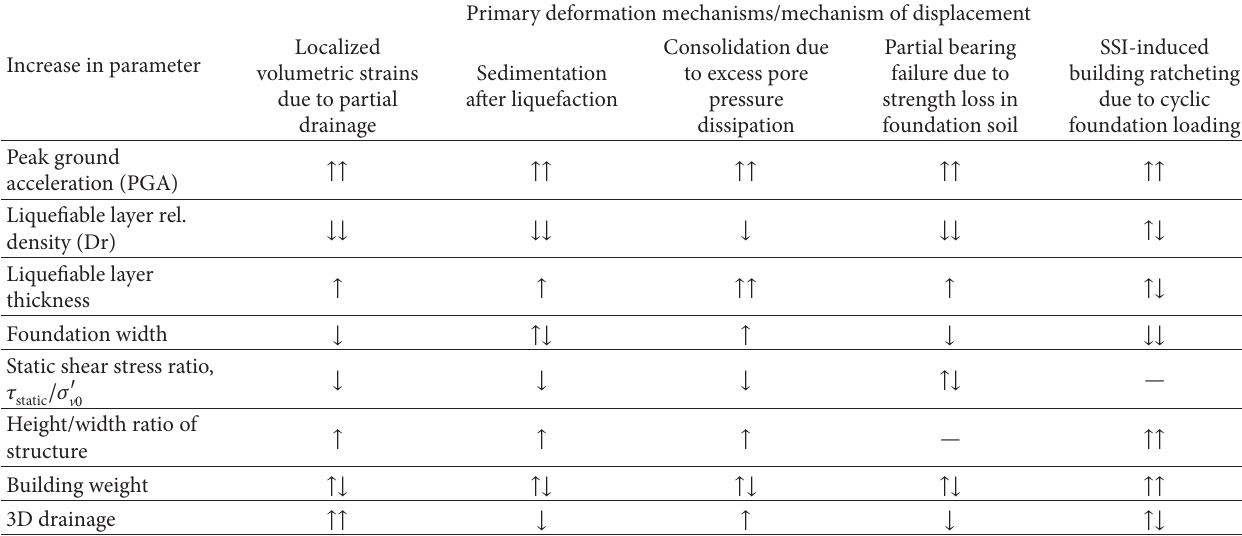
Table 2: Relation between mechanism of structural displacement and earthquake parameters as well as parameters of the structure.